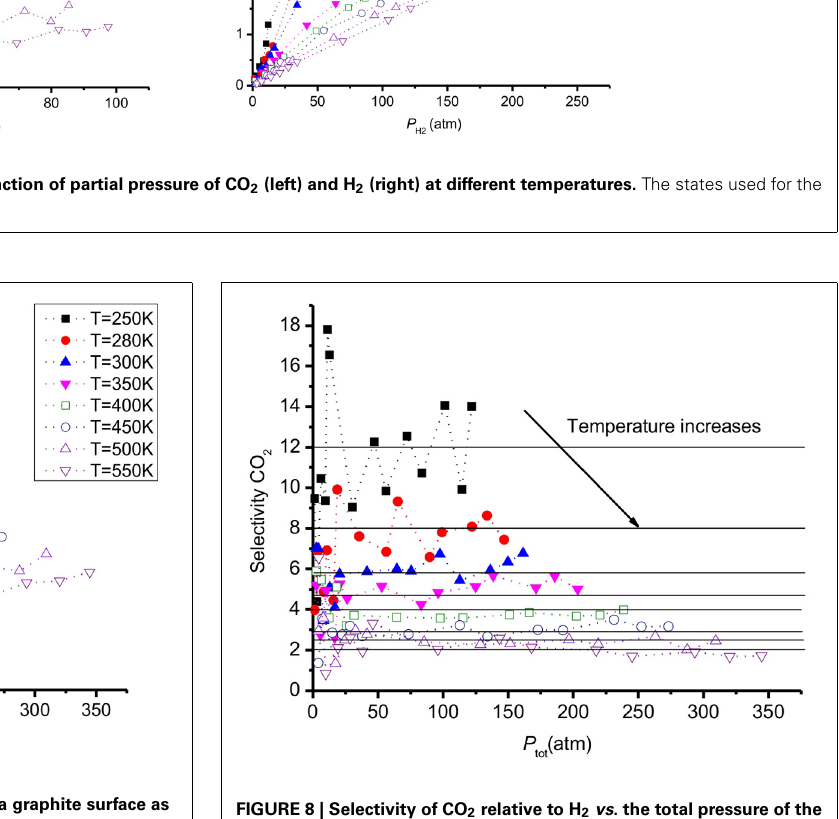
FIGURE 8 | Selectivity of CO 2 relative to H 2 vs . the total pressure of the system. Results refer to a graphite surface with pore size 7nm at different temperatures from 250 to 550K. The selectivity decreases with increasing